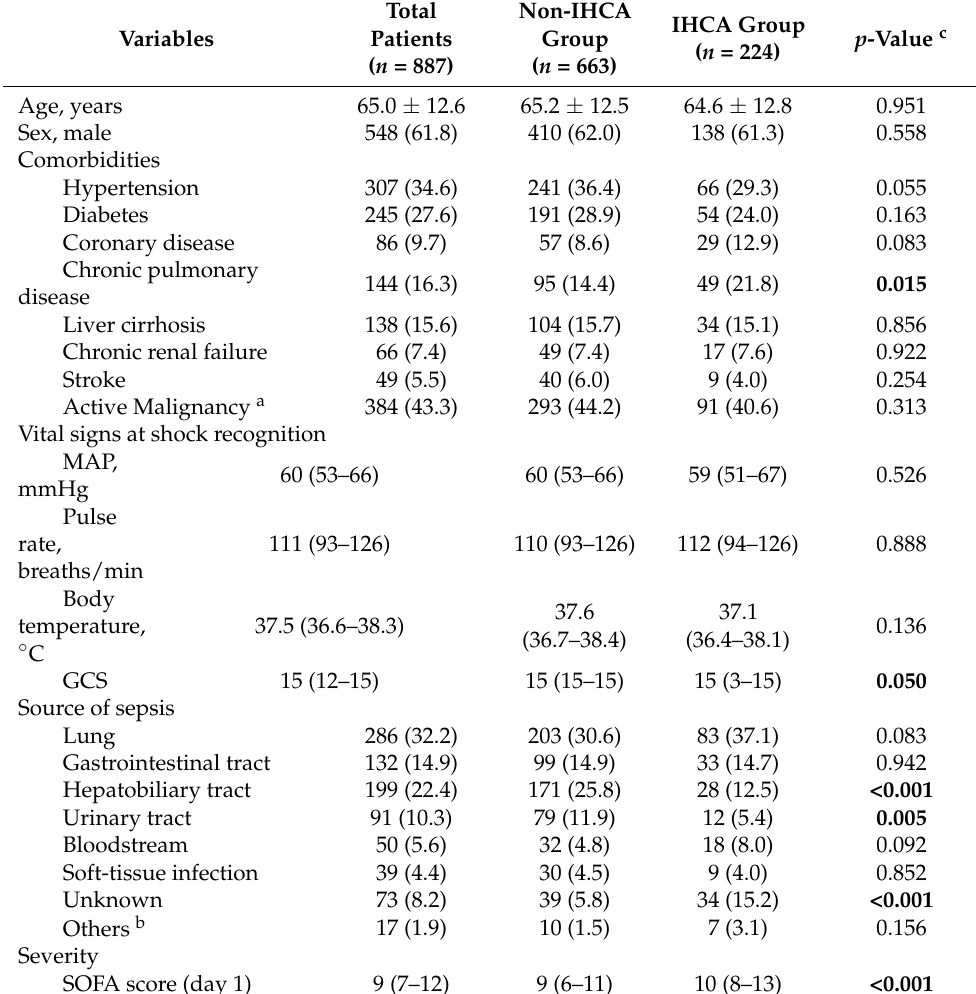
Table 1. Comparison of baseline and clinical characteristics between the IHCA and non-IHCA